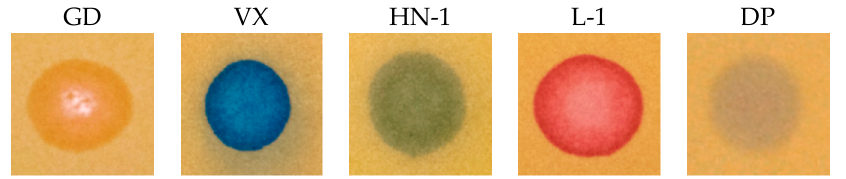
Figure 9. Functional stability of the RM1a/PY-OPD/BCG detection paper after 20 days of storage at a temperature of 80 °C.